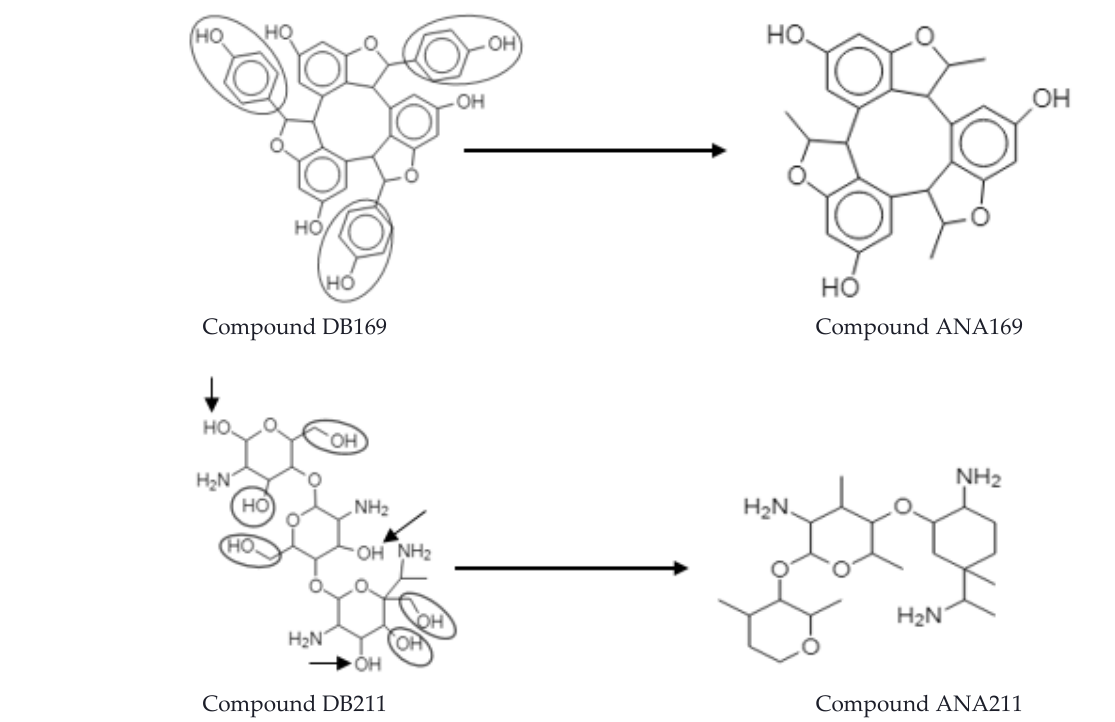
Figure 14. Optimization of some AMNPs with a low desirability score. ( a ) shows the random optimization of DB169 (α-viniferin) to produce ANA169. ( b ) shows the random optimization of DB211 (aminoethyl-chitosan) to produce ANA211. The round circles highlight the atoms that were replaced with a non-polar functional group (CH 3 ), and the arrows are pointing to the atoms that were removed during optimization.